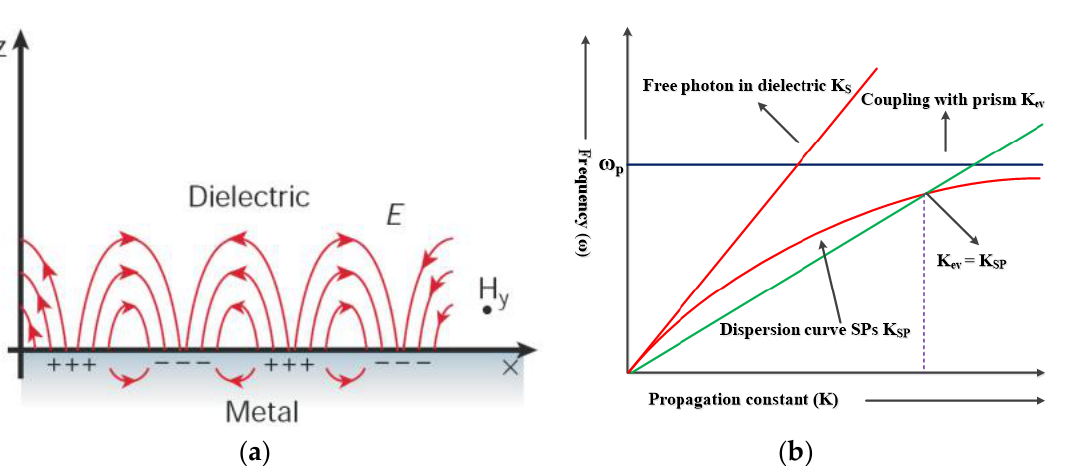
Figure 1. ( a ) Electric field lines and charge distributions associated with a surface plasmon traveling on a metal – dielectric interface [43]; ( b ) dispersion curves of light in free space and the surface plasmon [40, 44].